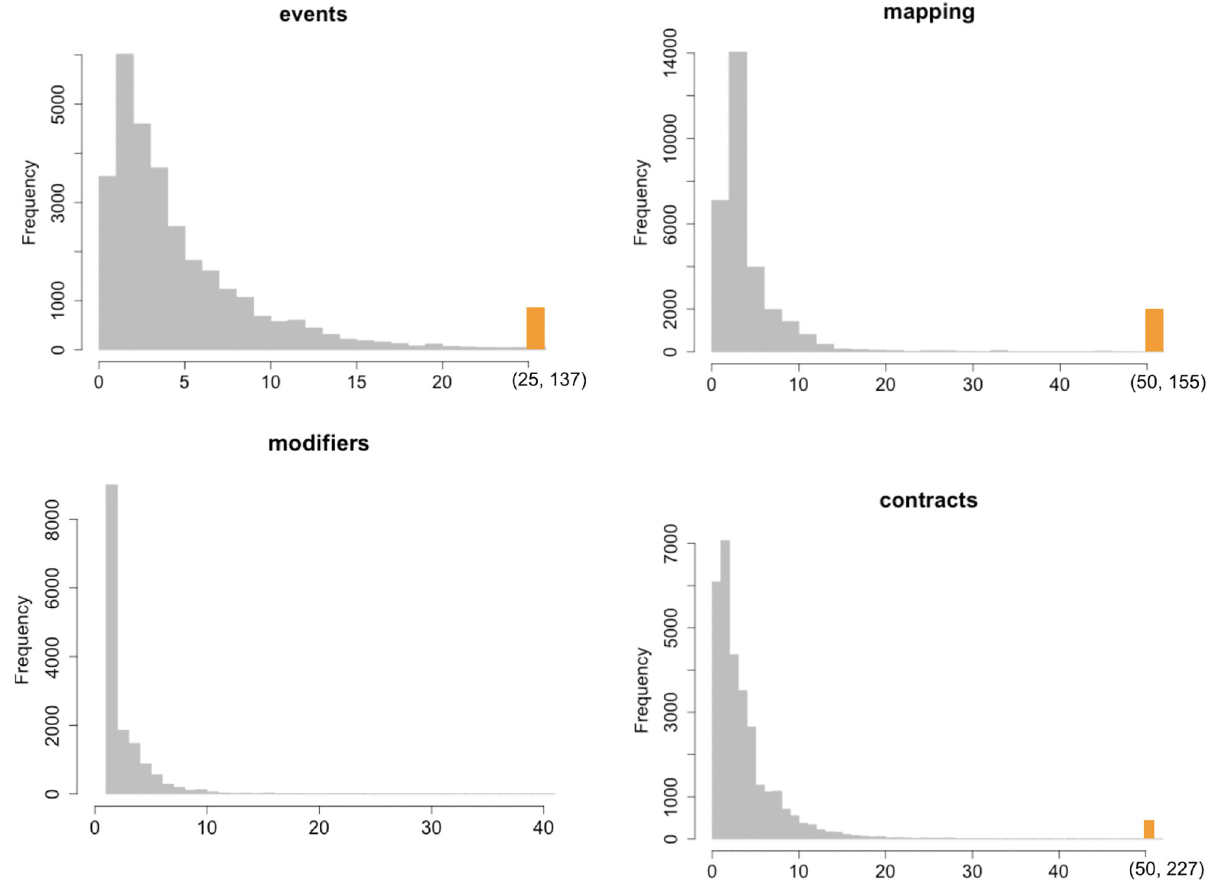
Fig 4. Histogram distributions of the metrics Events, Mapping, Modifier and